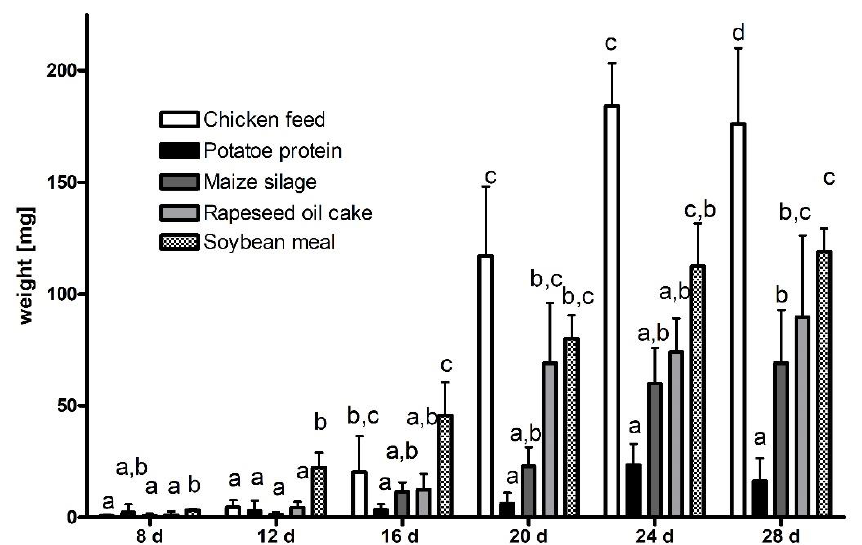
Figure 2. Weight (mean ± SD, n = 10) of Black soldier fly larvae Hermetia illuscens feeding on chicken feed (control), potato protein (P), maize silage (M), rapeseed oil cake (R), soybean meal (S) substrate over an experimental period of 28 d. Significant differences between groups at a given timepoint are indicated by different letters ( p > 0.05, n = 10).